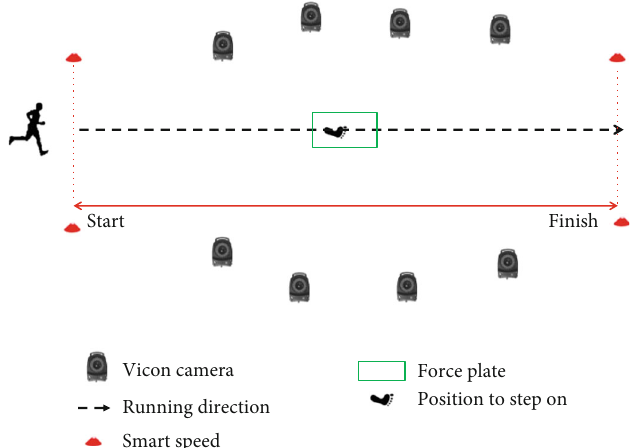
Figure 2: Participant motion capture setup.